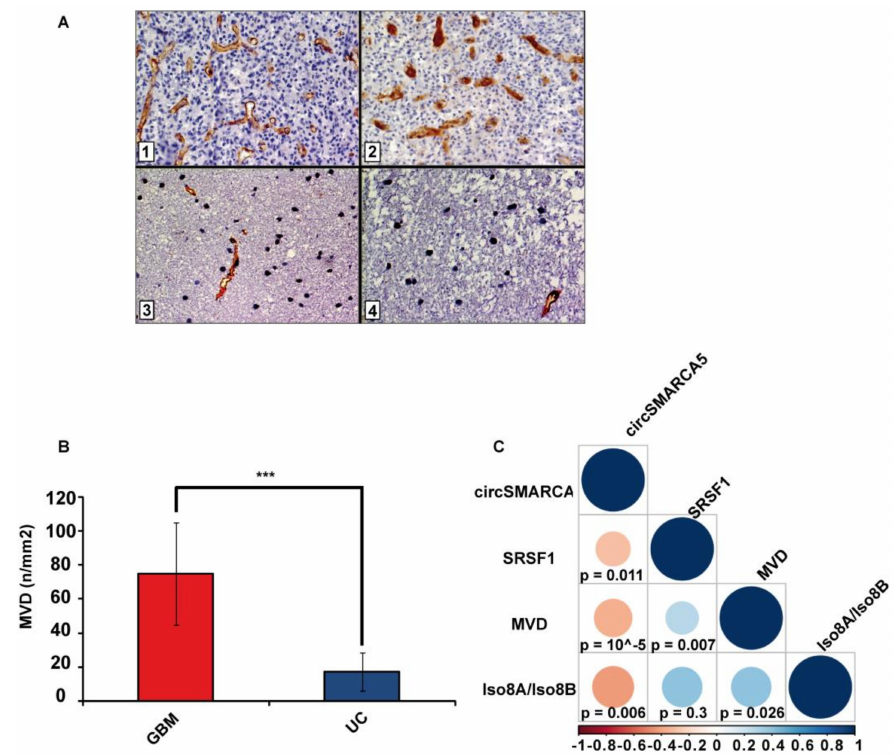
Figure 4. MVD in GBM and UC samples. ( A ) Representative immunohistochemical staining for CD31 showing areas of high MVD with multiple branching vessels in glioblastoma tissue (1 and 2) and a lower MVD in unaffected brain tissue (3 and 4). Immunoperoxidase staining; 400 × magnification ( B ) Bar graph representing the mean MVD in GBM and UC samples. Data are represented as mean ± standard deviation (*** p -value < 0.00001, N (GBM) = 31, N (UC) = 18, two sample t -test). ( C ) Correlation matrix among MVD, circSMARCA5 and SRSF1 expression and Iso8a to Iso8b ratio. Positive and negative correlations are displayed in blue and red color, respectively. Color scale bar indicates r values. Color intensity and the size of the circle are proportional to the correlation coefficients into the